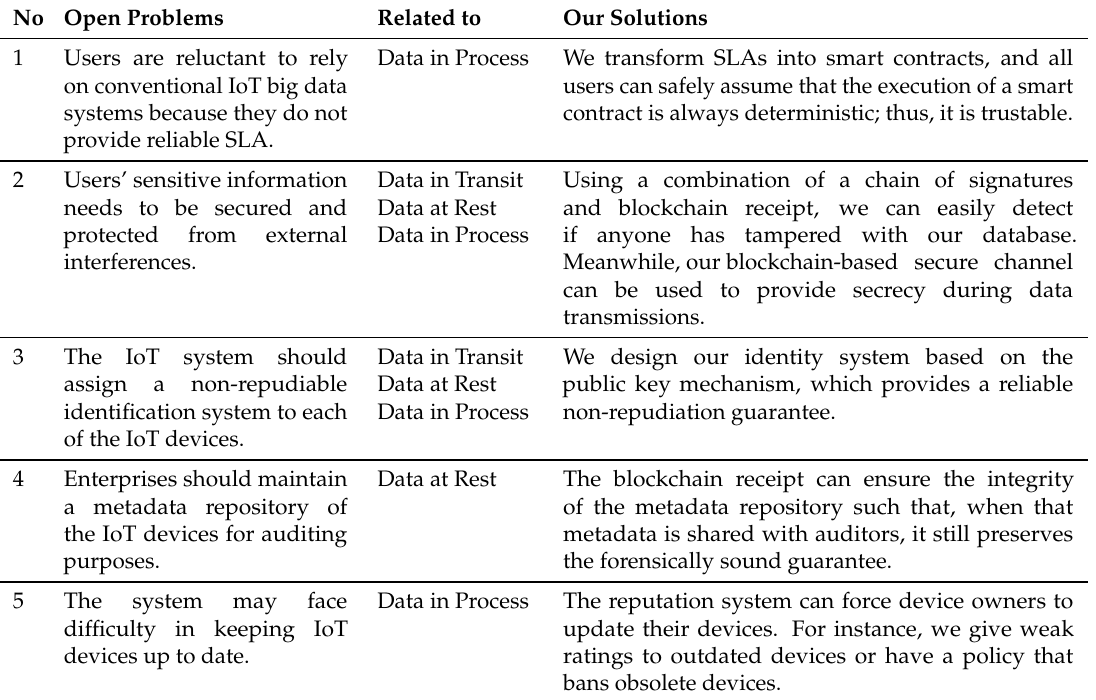
Table 8. Summary of how our proposed design can tackle open problems mentioned in